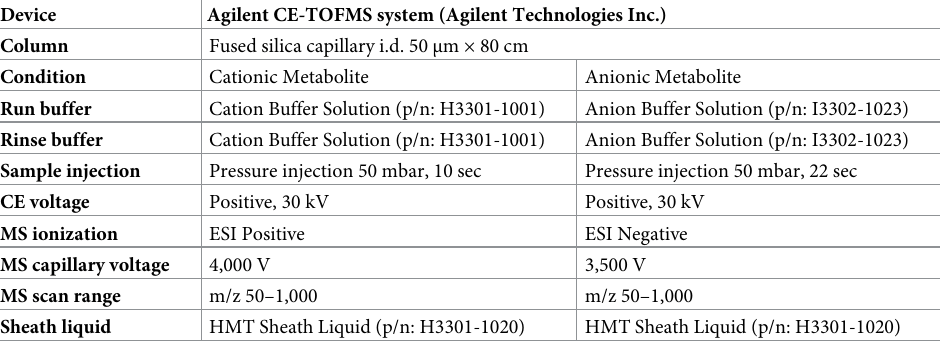
Table 2. CE-TOF/MS conditions for obtaining the metabolome profiles from red seabream muscle samples.